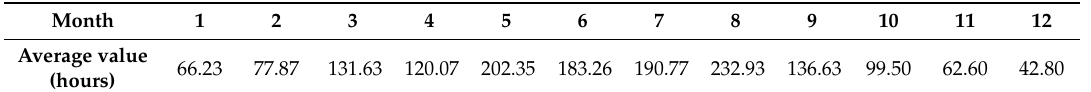
Table 1. Average monthly sunshine duration [25].